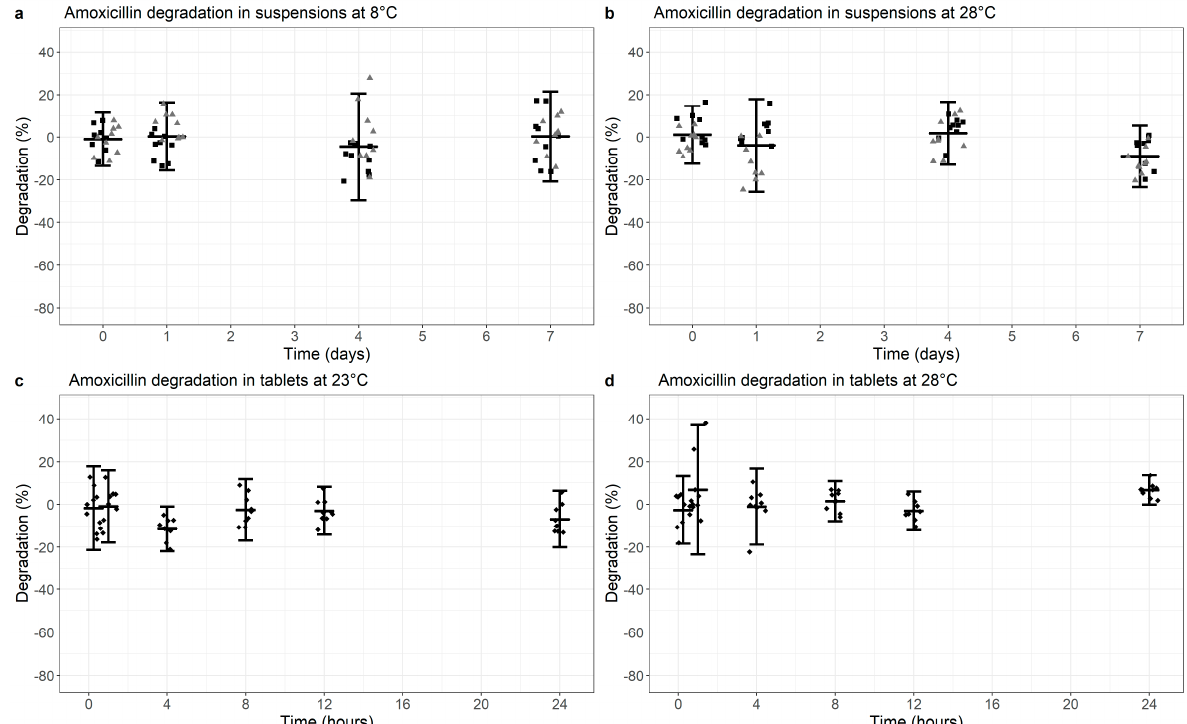
Figure 3. Degradation of Amoxicillin in non-co-formulated suspensions ( a , b ) at 8 °C ( a ) versus 28 °C ( b ) or tablets (dissolved; c, d) at 23 °C ( c ) versus 28 °C ( d ). Degradation is normalized for the median value at time point 0 (0% degradation). Data points represent the normalized individual measurements for Mepha (square) and Sandoz (triangle) suspensions and Sandoz 1000 mg tablets (diamonds). Cross bar represents the mean and the whiskers indicate the 95% confidence interval (mean ± 2 SD) per time point.